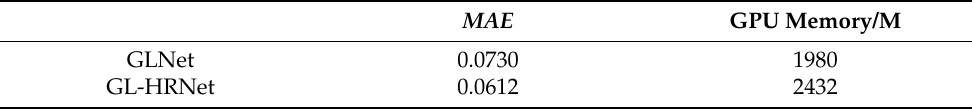
Table 4. Comparison of global branch experiments.